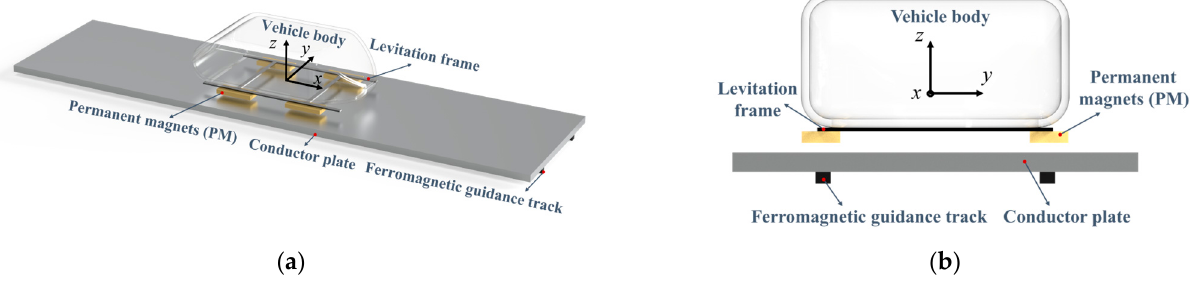
Figure 1. Schematic diagrams of the new EDS structure: ( a ) Overall structure diagram of the new EDS structure; ( b ) Side view of the new EDS structure.